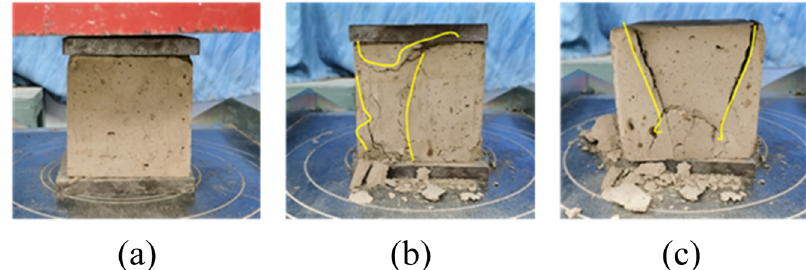
Figure 5: Cube compressive failure form; ( a ) prophase, ( b ) medium term, and ( c ) anaphase.